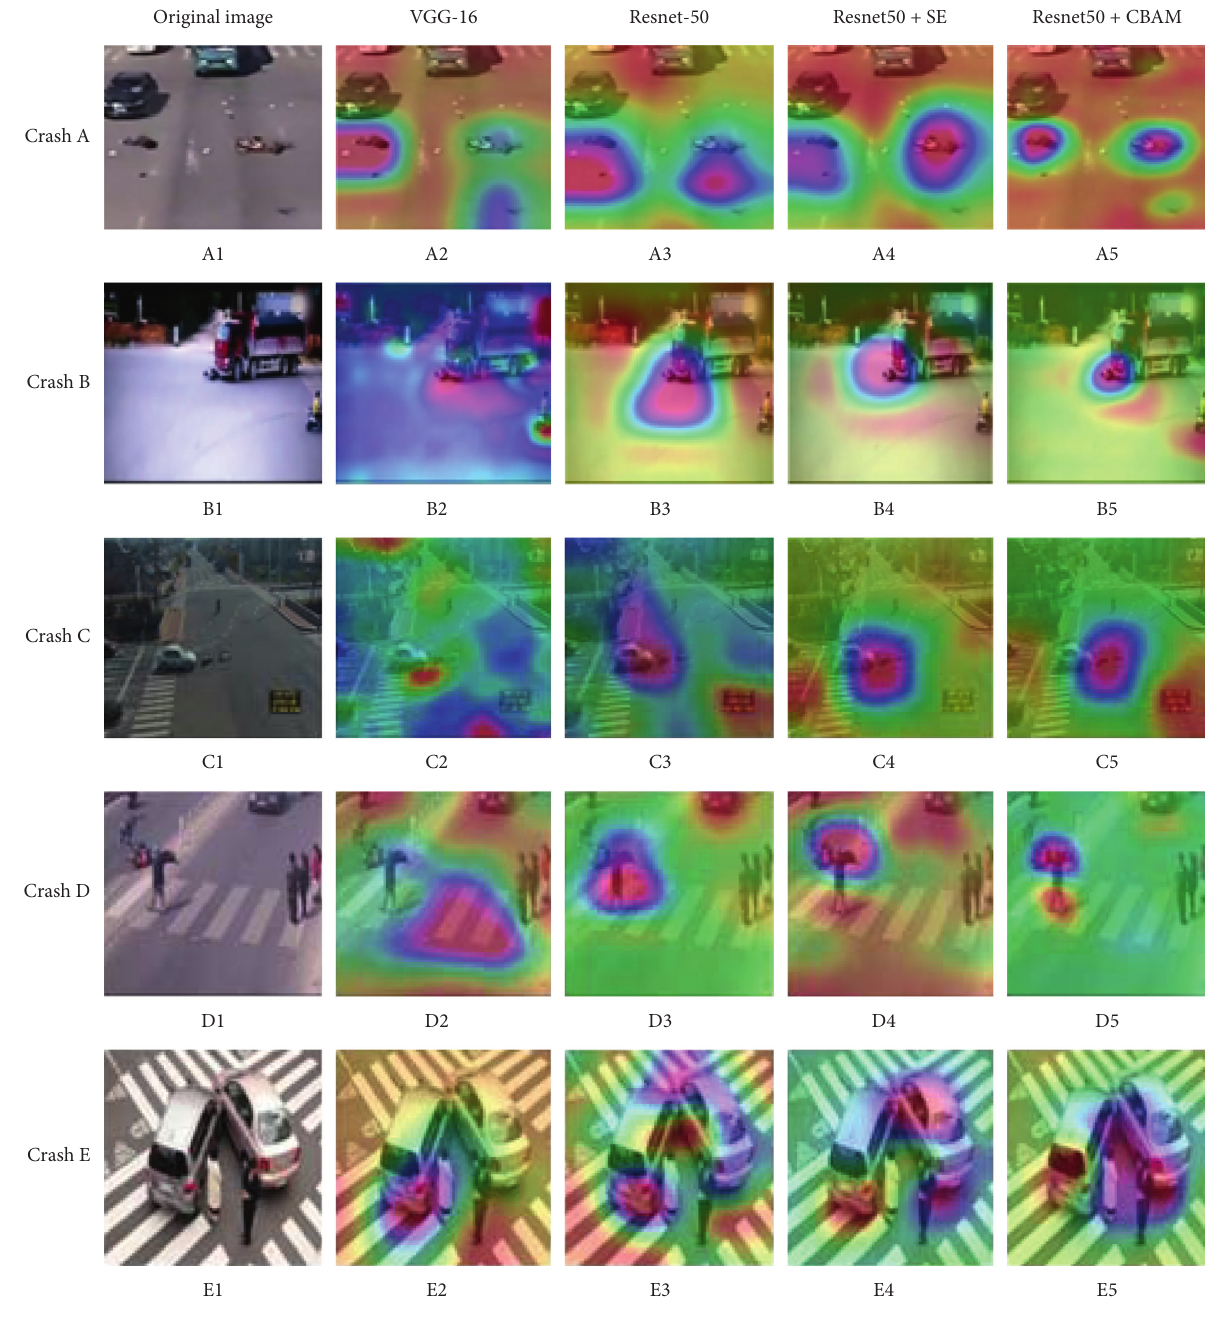
Figure 9: Crash appearance feature extraction